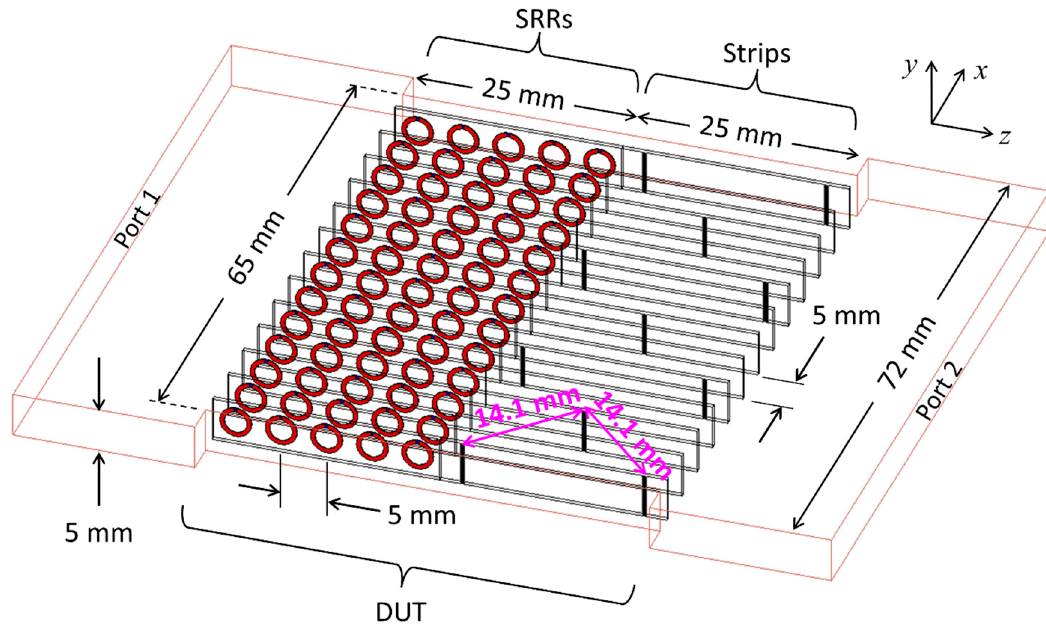
Figure 4. Rendering of one layer of the DUT containing the SRR array (MNG)/strip array (ENG) interface. (In color.).